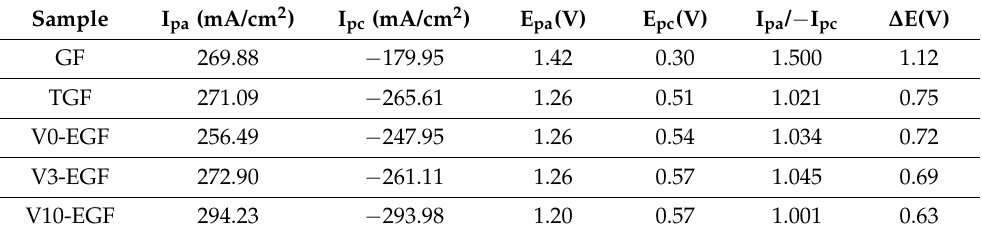
Figure 5. The CV curves of the graphite felt recorded at 30 mVs − 1 scan rates in 0.1 M VOSO 4 + 20 wt% H 2 SO 4 solution. Table 2. Summary of CV result when scan rates 30 mVs − 1 were used.